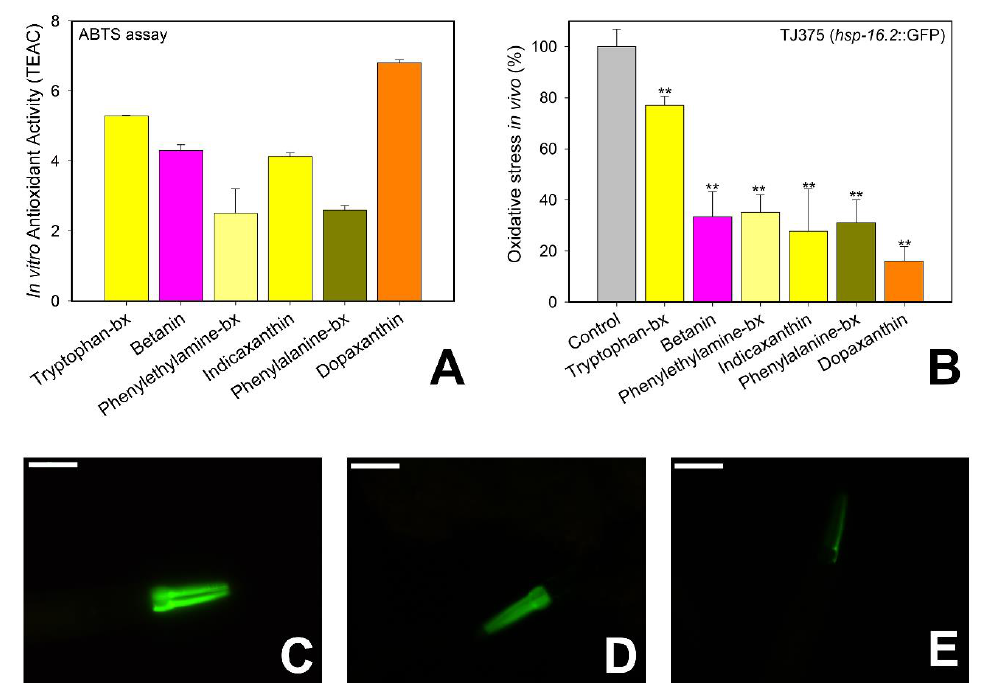
Figure 6. Antioxidant effects of the pure betalains tested in vitro and in vivo. ( A ) Results of the antioxidant capacity in vitro measured by the ABTS assay. ( B ) Results of the antioxidant activity in vivo with the C. elegans strain TJ375 treated with the tested betalains (25 μM) and exposed to the oxidant agent juglone (20 μM). ( C – E ) Representative fluorescence images of the strain TJ375, ( C ) control animal exposed to juglone, ( D ) animal treated with tryptophan-betaxanthin (25 μM), ( E ) animal treated with dopaxanthin (25 μM). ** Statistically significant at p ≤ 0.05. Scale bar: 50 μm. 3.6. Pure betalains and Natural Extracts Evaluation as Modulators of the Longevity Pathway Usually antioxidant molecules protect cells and organisms against oxidative stress either by radical scavenging or by modulation of transcription pathways like the insulin signaling pathways or the redox-active Nrf2/ARE signaling pathway [48]. To analyze the effects of the pure betalains and natural extracts tested in this work as modulators of the insulin signaling pathway, the C. elegans mutant strain TJ356 was used. The TJ356 strain expresses GFP fused with the DAF-16 transcription factor, homologue to the mammalian transcription factor FOXO. When the insulin signaling pathway is inactivated the GFP fluorescence is translocated from the cytoplasm to the nuclei of the cells. As shown in Figure 7C,G, tryptophan-betaxanthin induced a 77.1% nuclear translocation of DAF-16, an indication that the molecule is able to activate the insulin signaling pathway. This result supports the findings in Kuan-Chung et al. [33], where a modulation of SIR-2.1 (mammalian Sirt 1 protein) could